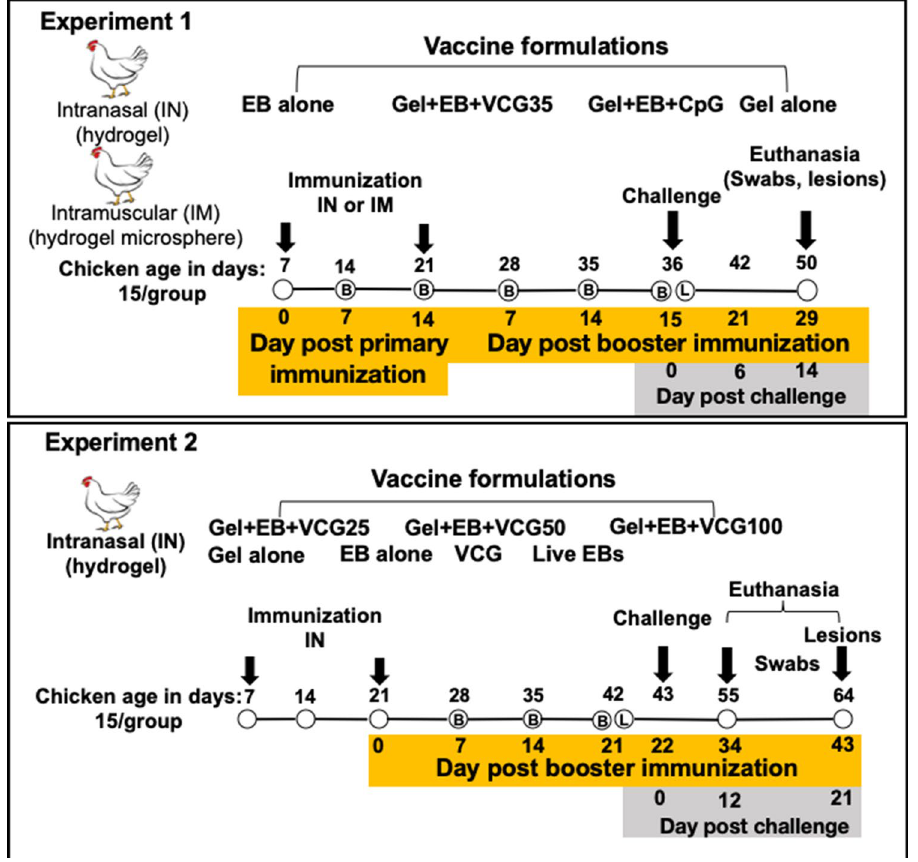
Figure 1. Schematic diagram of the experimental design outlining the immunization, challenge, and sample collection schedules. B, Blood samples; L, Lung lavage